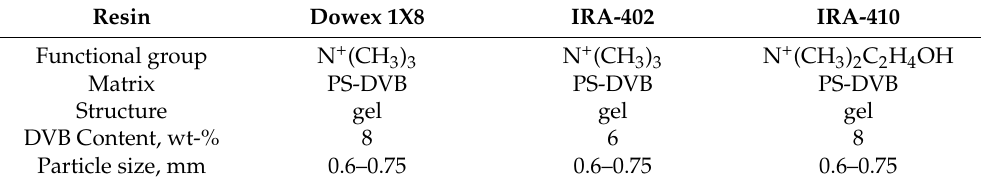
Figure 1. Functional groups of ( a ) Dowex 1X8 and IRA-402; ( b ) IRA-410; ( c ) MGDA-Na 3 . Table 2. Physical and chemical properties of the resins used in this study.